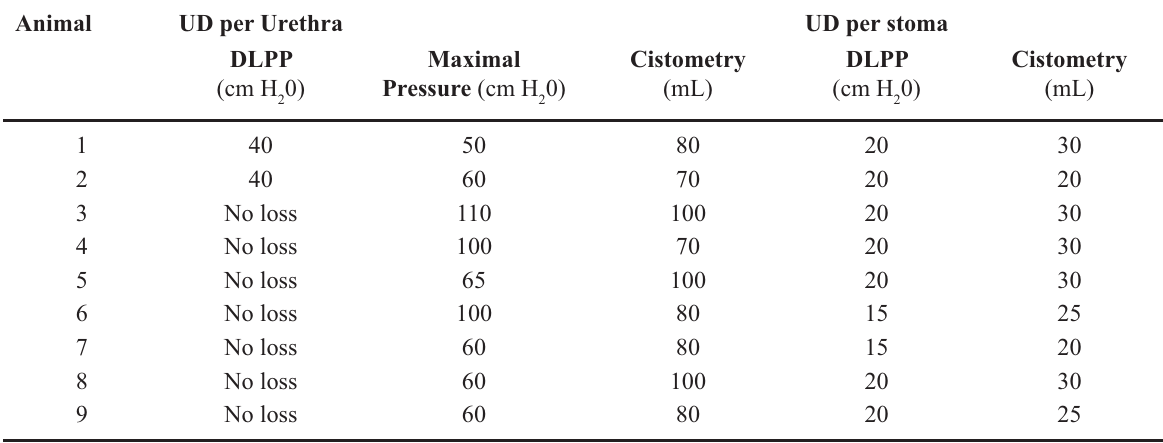
Table 1 – (cid:3)(cid:56)(cid:85)(cid:82)(cid:71)(cid:92)(cid:81)(cid:68)(cid:80)(cid:76)(cid:70)(cid:3)(cid:85)(cid:72)(cid:70)(cid:82)(cid:85)(cid:71)(cid:86)(cid:3)(cid:82)(cid:73)(cid:3)(cid:83)(cid:82)(cid:86)(cid:87)(cid:82)(cid:83)(cid:72)(cid:85)(cid:68)(cid:87)(cid:76)(cid:89)(cid:72)(cid:3)(cid:72)(cid:89)(cid:68)(cid:79)(cid:88)(cid:68)(cid:87)(cid:76)(cid:82)(cid:81)(cid:3)(cid:68)(cid:87)(cid:3)(cid:22)(cid:19)(cid:87)(cid:75)(cid:3)(cid:83)(cid:82)(cid:86)(cid:87)(cid:82)(cid:83)(cid:72)(cid:85)(cid:68)(cid:87)(cid:76)(cid:89)(cid:72)(cid:3)(cid:71)(cid:68)(cid:92)(cid:3)(cid:11)(cid:72)(cid:91)(cid:70)(cid:72)(cid:83)(cid:87)(cid:3)(cid:68)(cid:81)(cid:76)(cid:80)(cid:68)(cid:79)(cid:86)(cid:3)(cid:74)(cid:85)(cid:82)(cid:88)(cid:83)(cid:3)(cid:20)(cid:12)(cid:17) Animal UD per Urethra UD per stoma